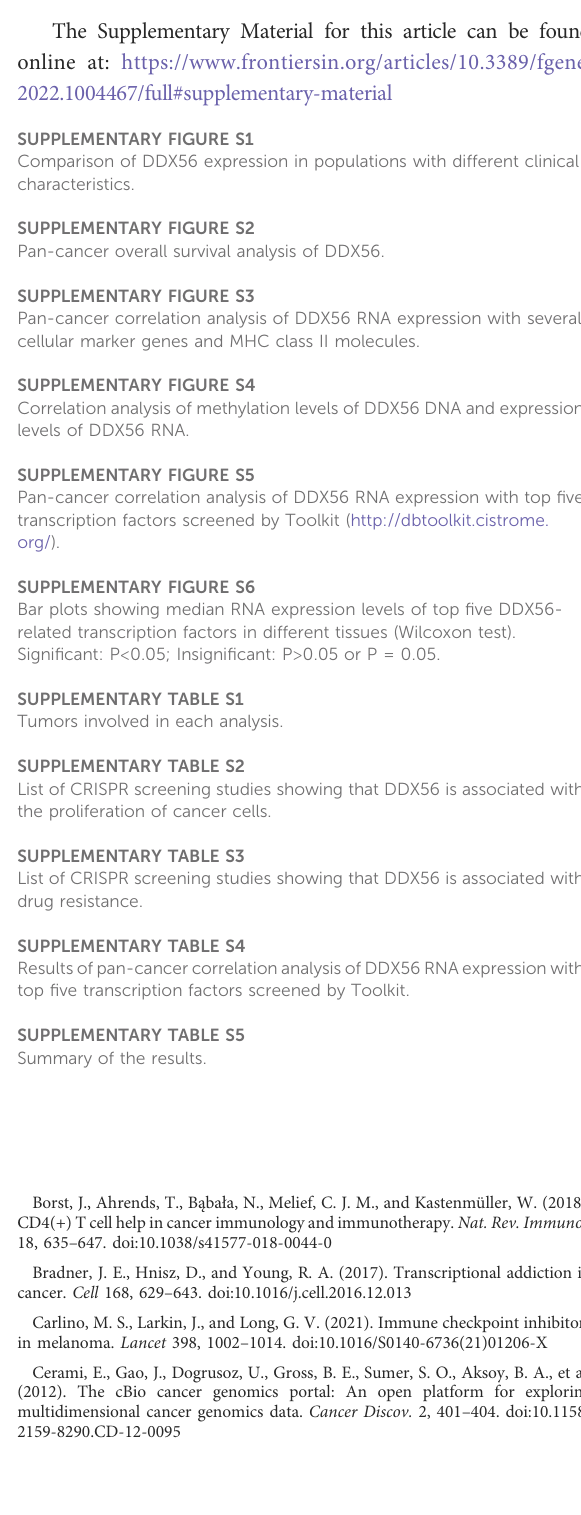
Comparison of DDX56 expression in populations with different clinical characteristics.